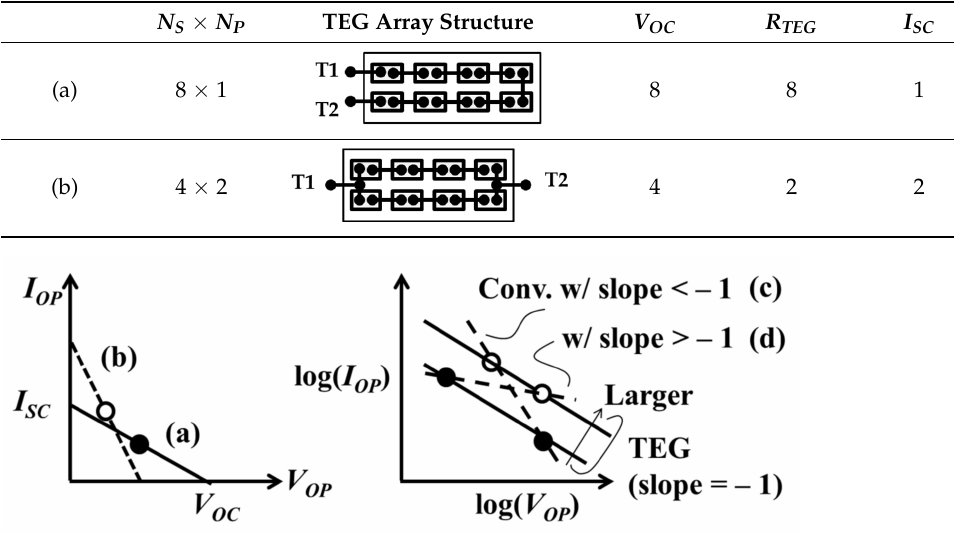
Figure 4. V OP − I OP curves of the TEGs (a) and (b) shown in Table 1 and those of the converters whose slope are smaller (c) or larger (d) than −